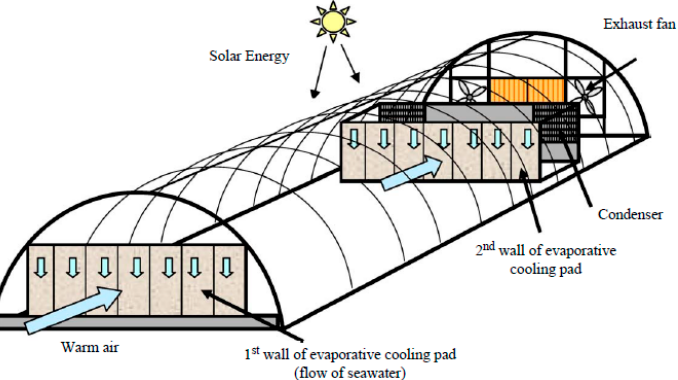
Figure 9. Water recovery in the evaporative cooling system of a seawater greenhouse in Oman. Reprinted with permission from Ref. [94]. Copyright 2005